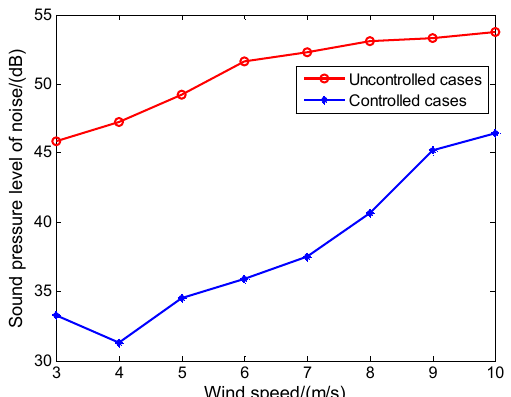
Figure 7. The noise contrast results: sound pressure level of noise between uncontrolled cases and the controlled cases with trailing-edge flap structure.